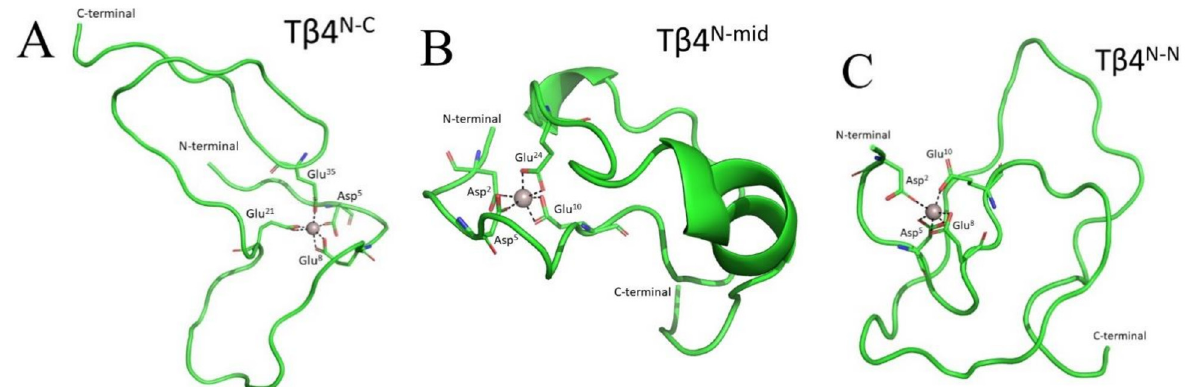
Figure 3. Representative structures of ( A ) T β 4 N-C ; ( B ) T β 4 N-mid and ( C ) T β 4 N-N . Figure was created by Gabriele dalla Torre, Euskal Herriko Unibertsitatea UPV/EHU. This image is original and designed specifically for the targeted publication. It should not be cropped, distorted, or in any way edited without the expressed consent of Research Publication